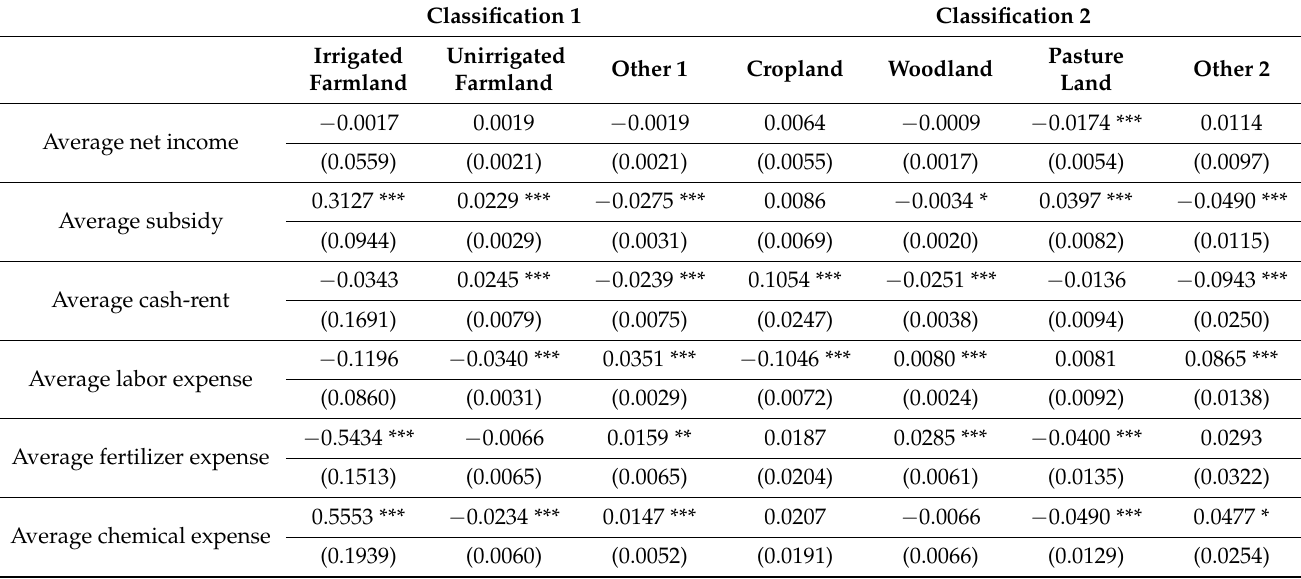
Table 6. Estimated Marginal Effects on Land-Use in Multinomial-Fractional-Logit